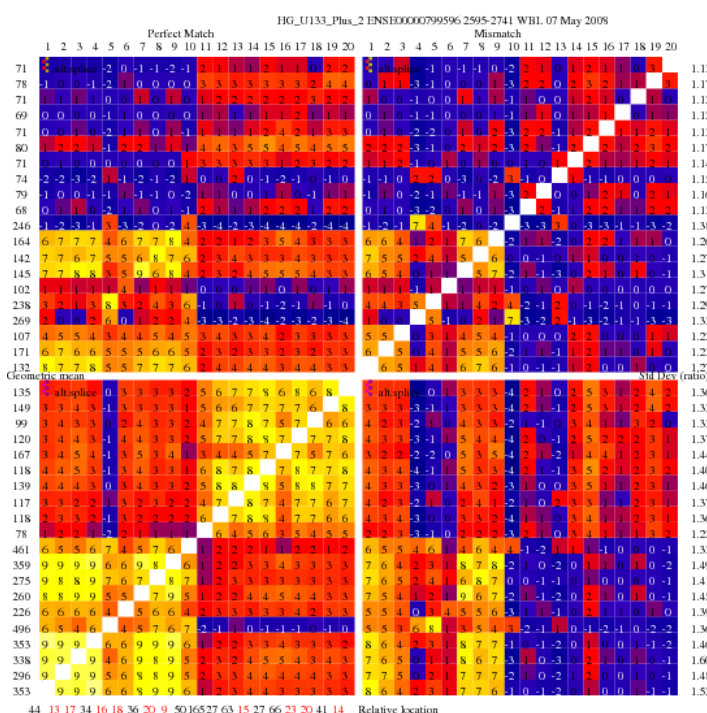
Figure 12: A correlation matrix for exon ENSE00000799596 with probes from HG-U133 Plus 2. Probes 1-10 align to the exon before a polyA site and probes 11-20 align after. The matrix suggests that there is a considerable population of GeneChips measuring transcripts that did not terminate at this site, because there is correlated expression beyond the site.